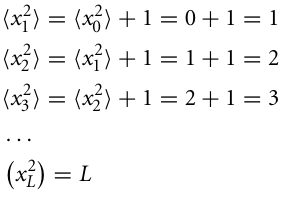
Let us define the starting position to be 0, i.e., the mean square displacement at time 0